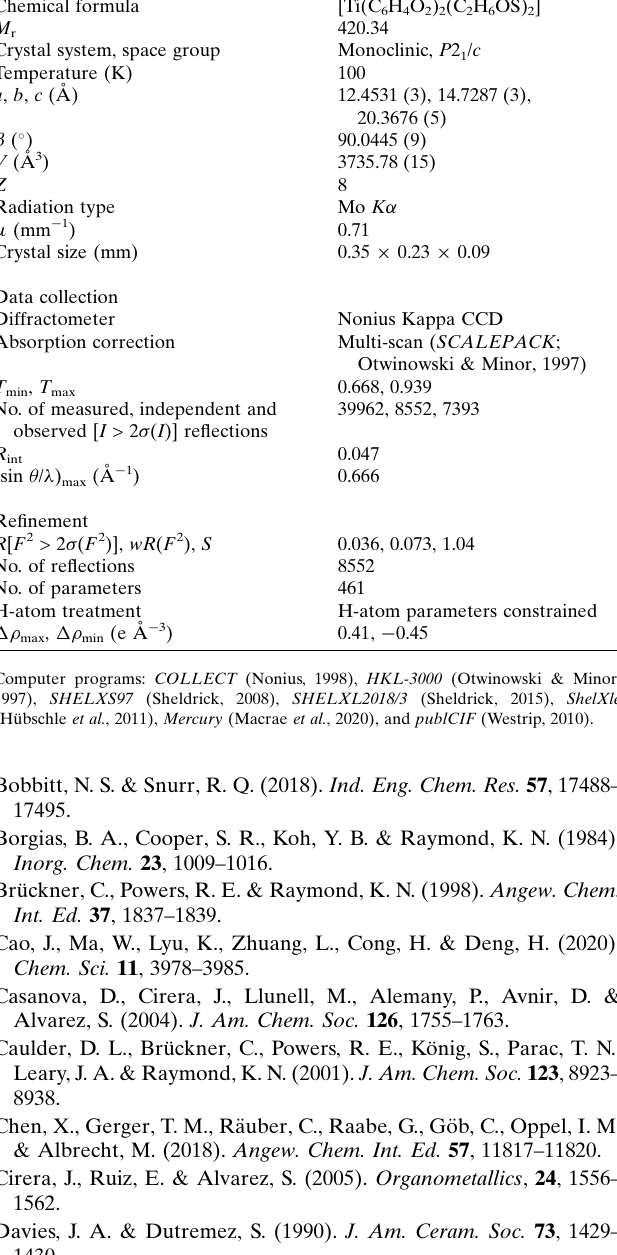
Crystal data Chemical